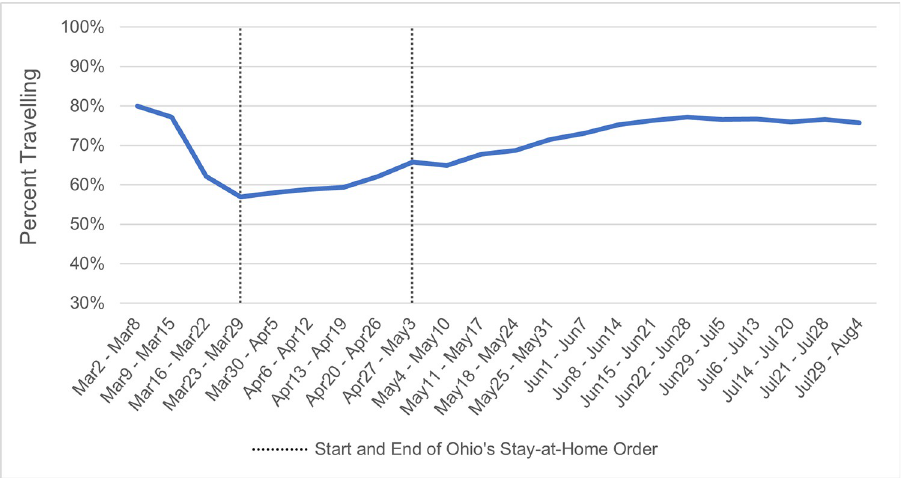
Fig 1. Percent of Ohioans staying home by week, adjusted for